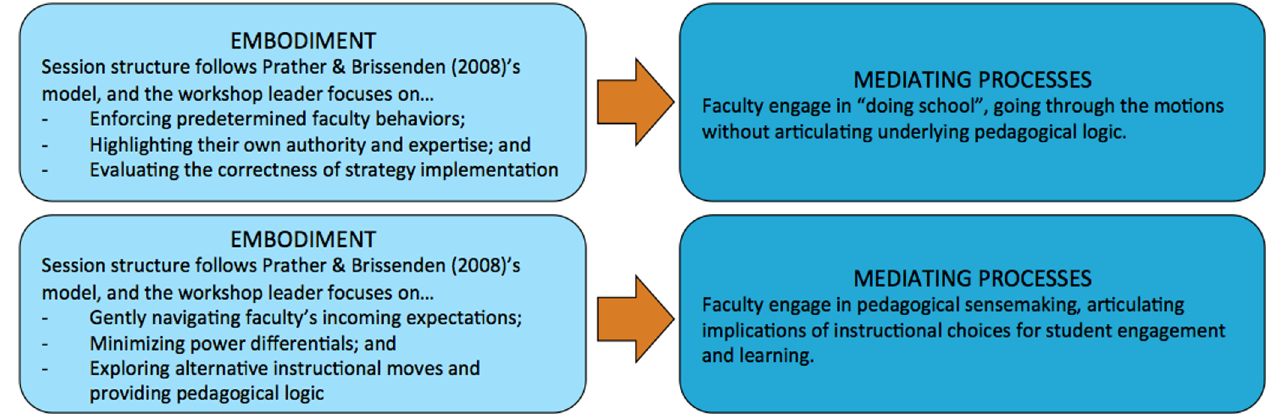
FIG. 2. A summary of our design conjectures, which take the form: If a workshop session is embodied in this way, then we expect to see these mediating processes